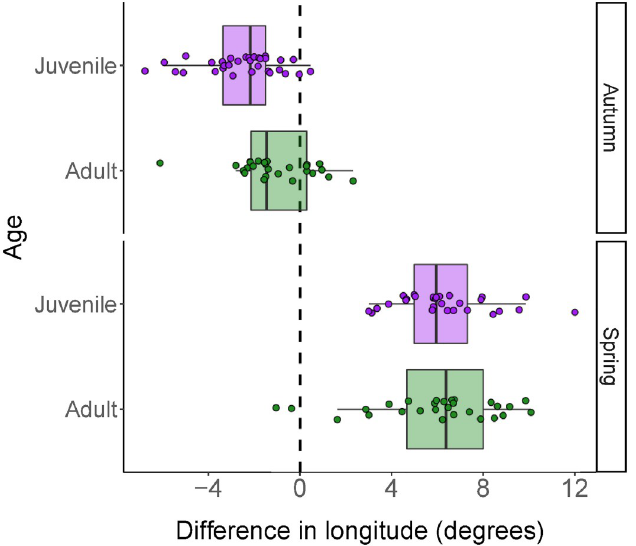
Fig 2. Juvenile Cyprus wheatear migrations are less direct than adults, but only in autumn. Differences in longitude (degrees) between the median longitude during migration and the longitude at the mid-point between the breeding grounds in Troodos, Cyprus, and non-breeding locations for autumn and spring migrations. Positive values reflect deviations to the east. Data were estimated from light-level geolocation data. Geolocator tags were deployed in 2017, 2018 and